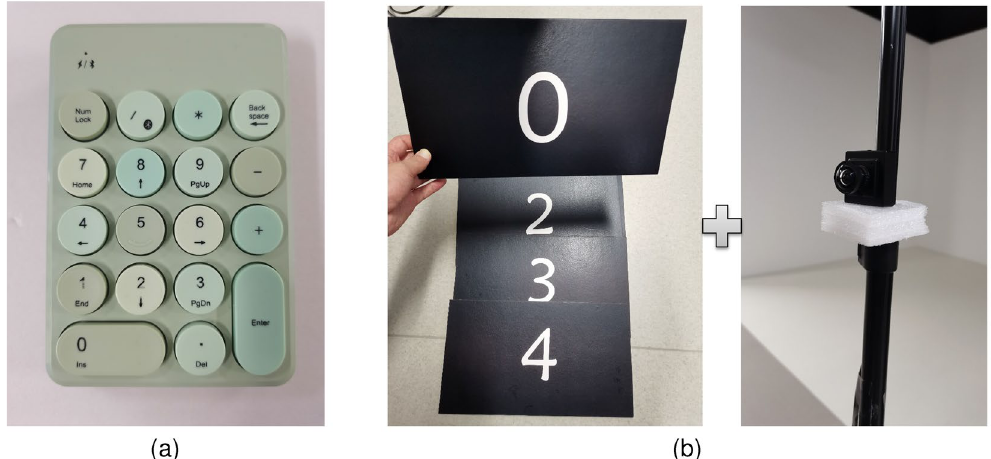
Figure 4. Some key components are used in the system hardware. ( a ) Bluetooth keyboard. ( b ) Physical boards (with five numbers) and an RGB